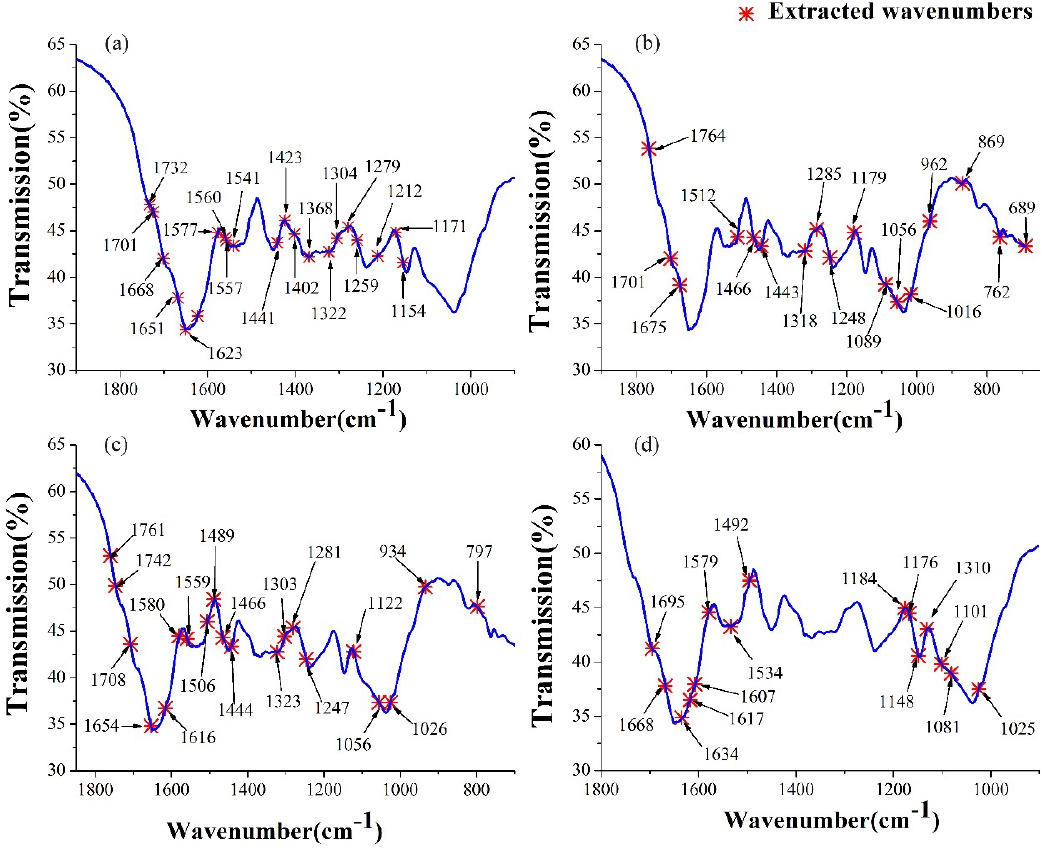
Figure 4. Extracted wavenumbers by biPLS and SPA for ( a ) Chl-b; ( b ) Chl-a; ( c ) Phe-b; ( d ) Phe-a.